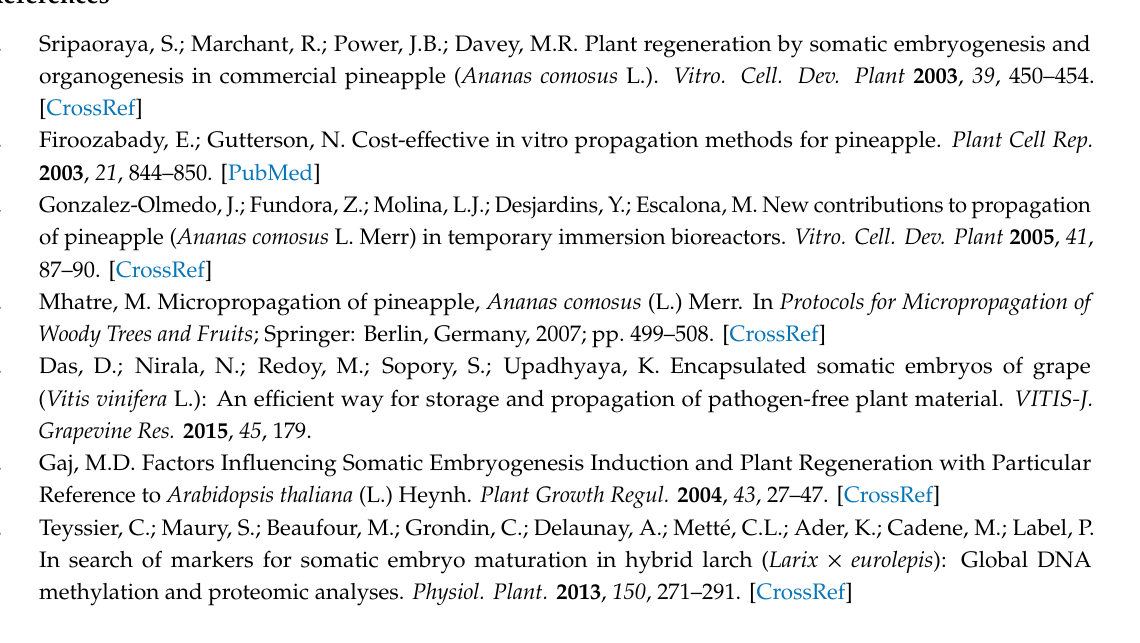
Figure S1: Structure of AcSERK1 5 (cid:48) upstream regulatory sequence deletion vectors., Figure S2: Structure of AcSERK1 5 (cid:48) upstream regulatory sequence deletion vectors, Figure S3: Distribution of CAAT-box on promoter sequences of 142 SERK family genes from 20 plant